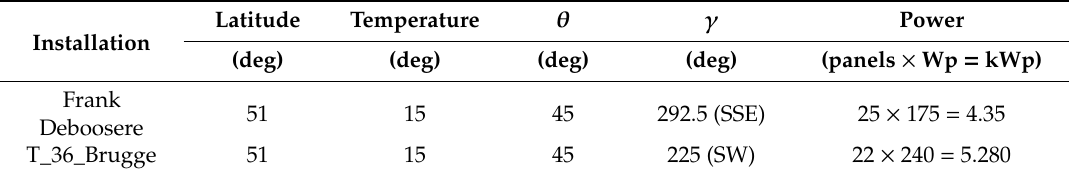
Table 2. Characteristics of two actual installation photovoltaic (PV) systems in Flanders, Belgium. Installation